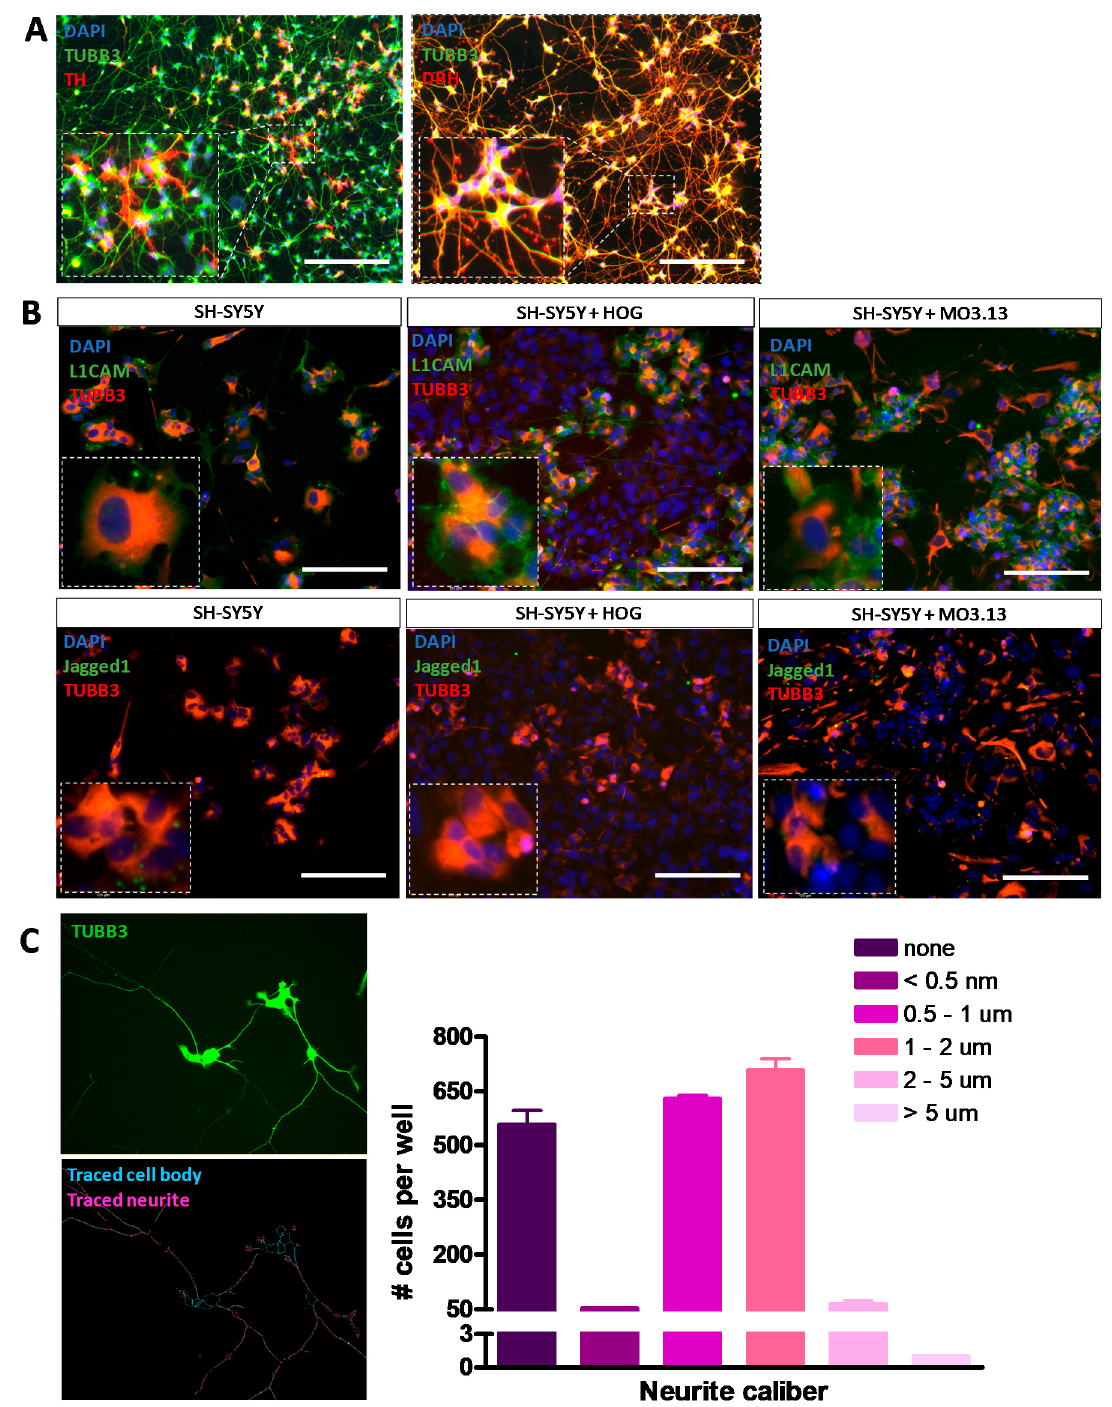
Figure 6. Immunocytochemical analysis of neuronal di ff erentiation in co-cultures of HOG or MO3.13 cells with di ff erentiated neuronal SH-SY5Y cells. ( A ) Representative images of for expression of mature neuronal markers TUBB3 and tyrosine hydroxylase (TH) or dopamine beta-hydroxylase (DBH) in di ff erentiated SH-SY5Y monocultures. ( B ) Representative images of Jagged1 and L1CAM surface expression and TUBB3 signals in SH-SY5Y monoculture, and SH-SY5Y + HOG and SH-SY5Y + MO3.13 co-cultures. Scale bar = 50 µ m. ( C ) Quantifications of neurite caliber in low density neurite networks of di ff erentiated SH-SY5Y cells ( n =